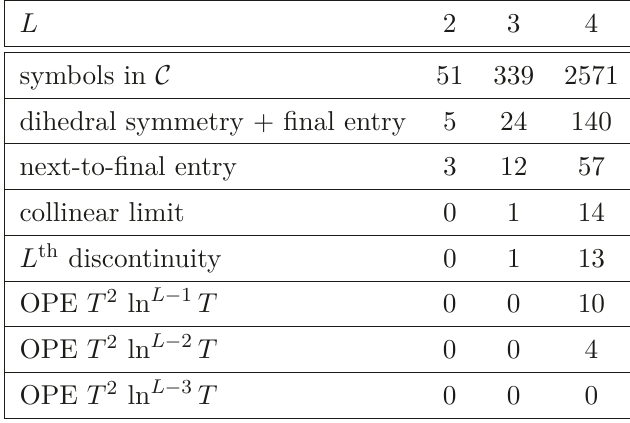
Table 5. Number of parameters left when bootstrapping the form factor E ( L ) at L -loop order in the function space C at symbol